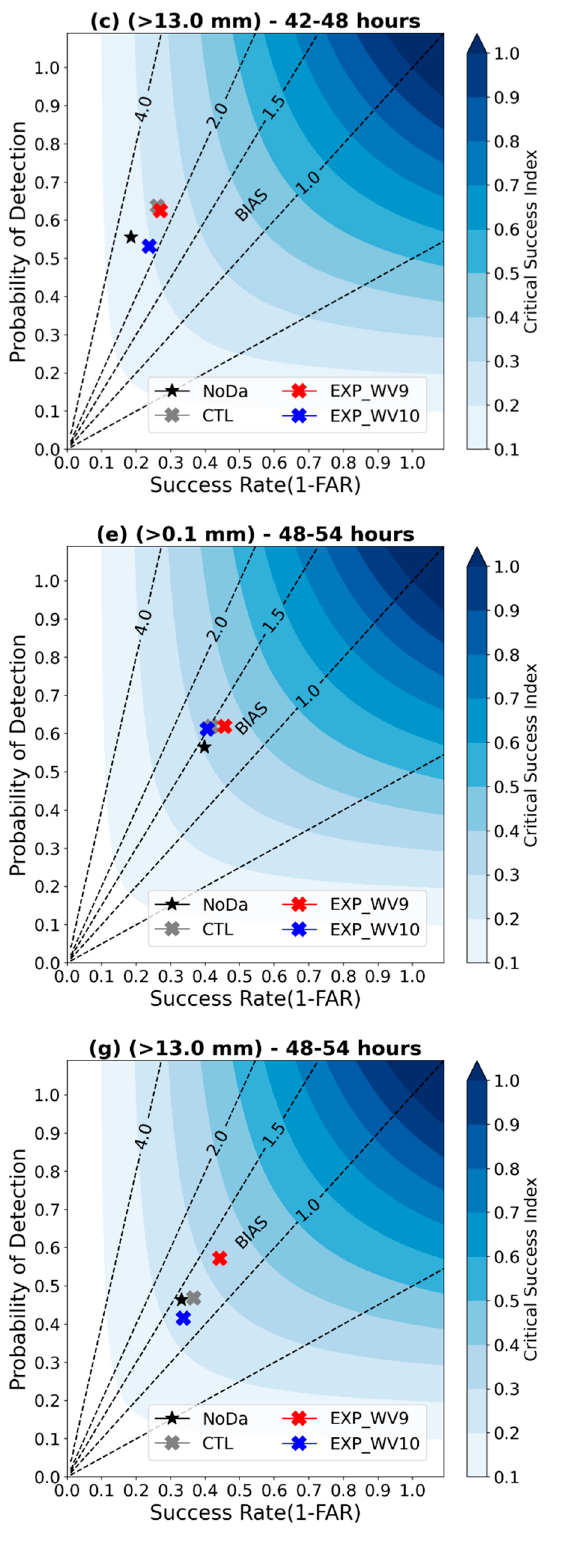
Figure 15. The same as Figure 14 except for the ( a – d ) 42–48 h forecast leading times and ( e – h ) 48–54 h forecast leading times.